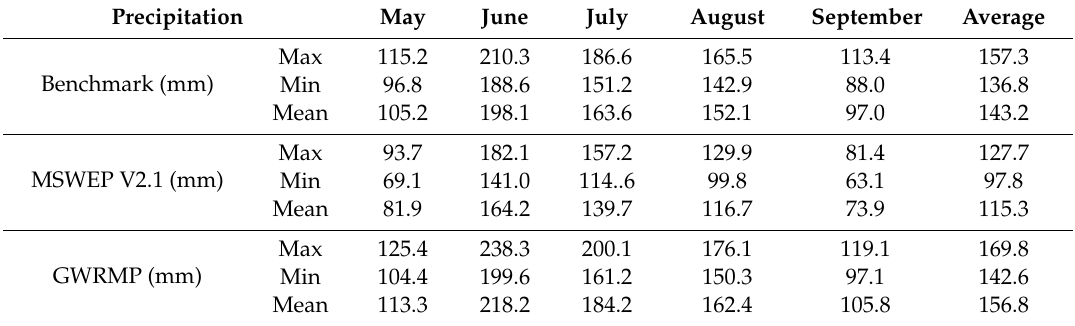
Figure 6. Spatial distribution of monthly precipitation in Taihu Lake based on three kinds of gridded precipitation. Table 1. Statistical analysis of annual average monthly precipitation in Taihu Lake based on three kinds of gridded precipitation.